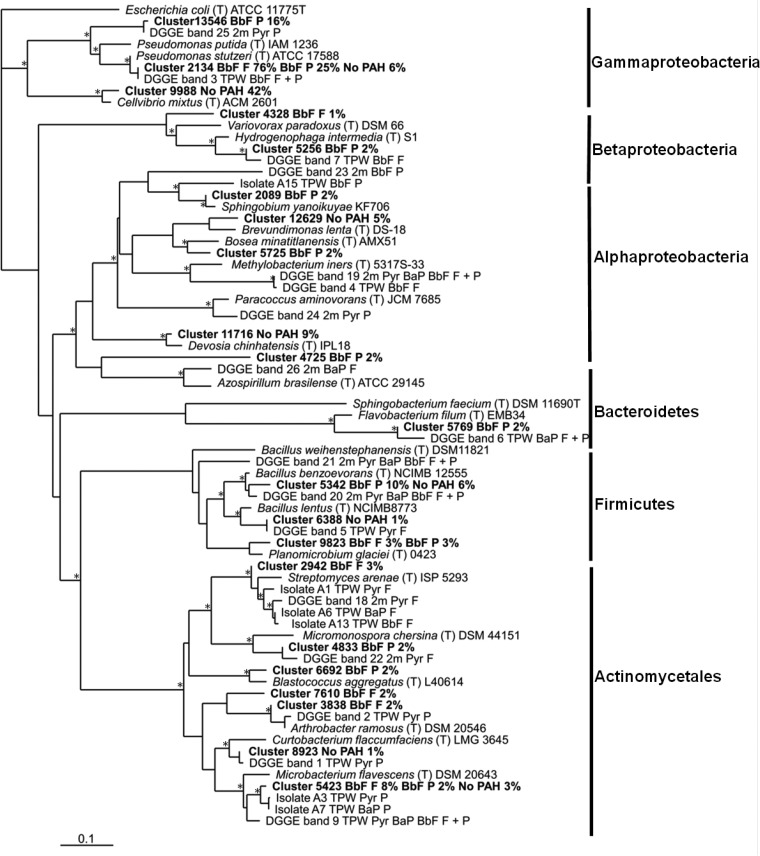
Phylogenetic analysis of selected 16S rRNA gene sequences from isolates, pyrosequencing, and DGGE from the HMW-PAH-degrading communities. For each OTU, the most closely related sequences from GenBank are also indicated. Sequence analysis was performed using the neighbor-joining method. Bootstrap values represent percentages from 100 replicates of the data, and those of >80% are shown by an asterisk. The scale bar indicates 0.01 substitution per nucleotide base. Pyr, pyrene enrichments; BaP, benzo[a]pyrene enrichments; BbF, benzo[b] fluoranthene enrichments; F, filter; P, planktonic.